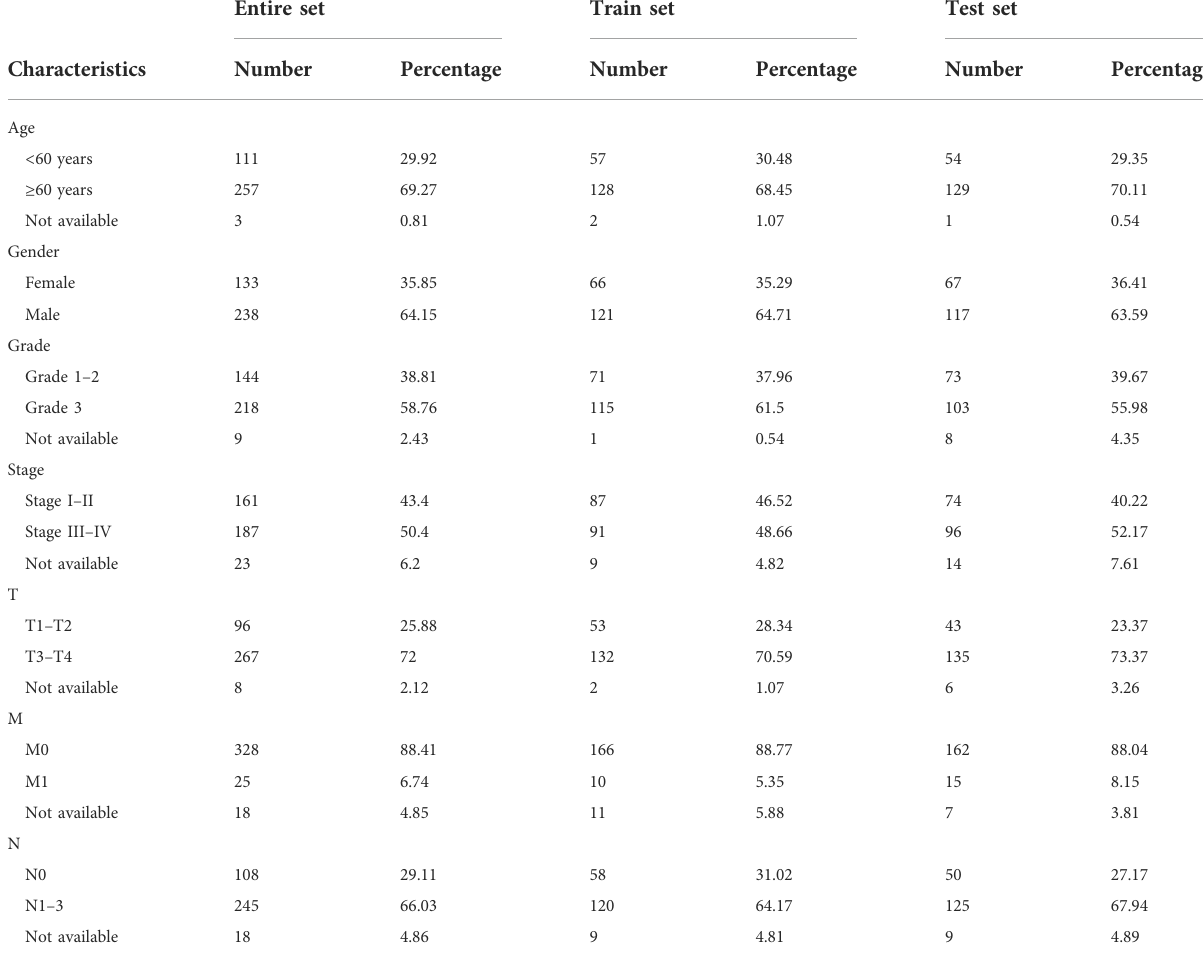
TABLE 1 Distribution of patients ’